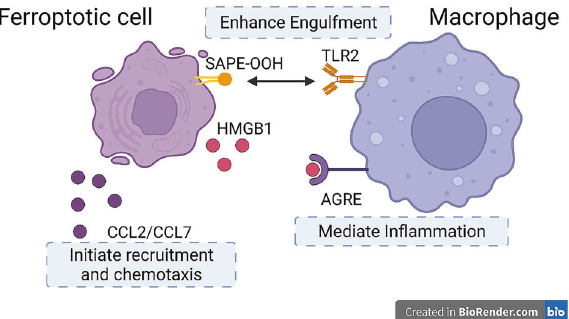
Fig. 6 Ferroptotic cells activate macrophages ’ functions and recruitment. In dealing with ferroptotic cells, TLR2 on macrophages identi fi es and binds to SAPE-OOH on the surface of ferroptotic cells to enhance engulfment. HMGB1 released by dying cells can interact with AGRE on macrophages in order to mediate in fl ammation reactions in macrophages. Some molecules like CCL2 or CCL7 can initiate the recruitment and chemotaxis of macrophages for intensity of immune reactions.